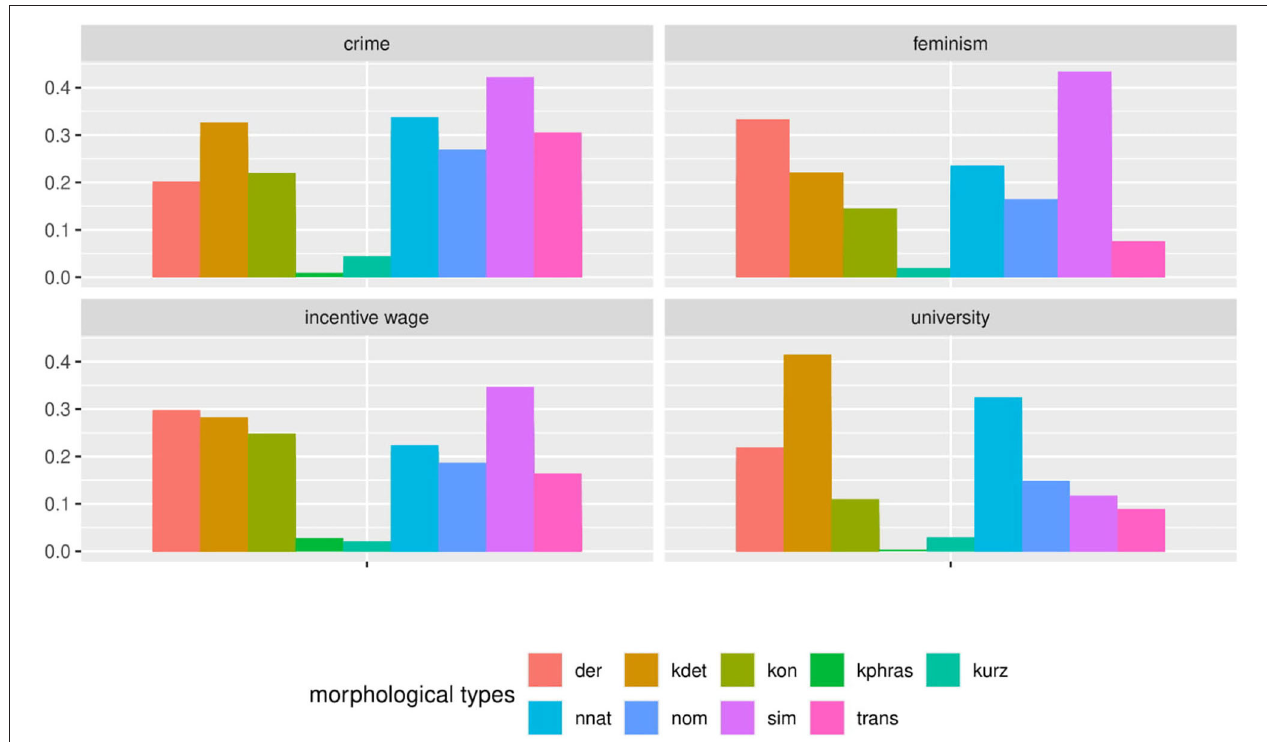
FIGURE 5 | The cumulative distribution of morphological types of nouns across Falko differs by topic. For instance, in the feminism topic simplex nouns are prevalent, whereas in the university topic non-native nouns and determinative compounds are the largest